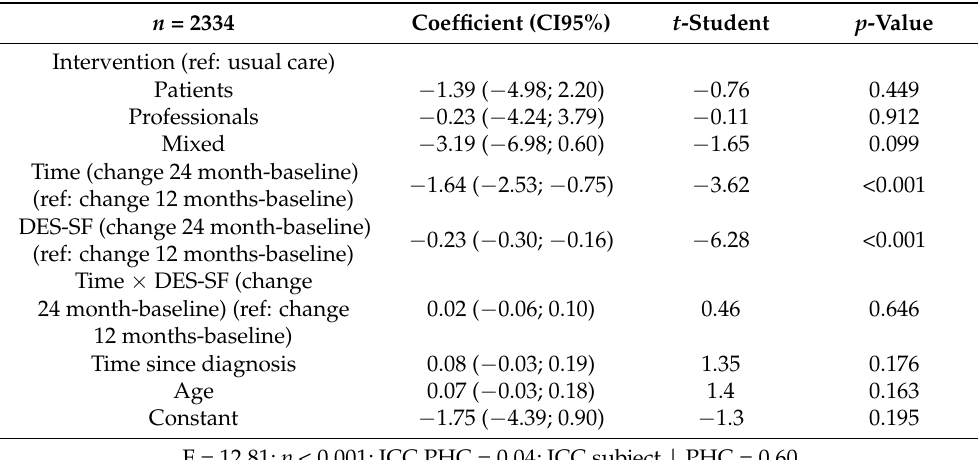
Table 5. Regression model for change in state-anxiety (STAI-S).